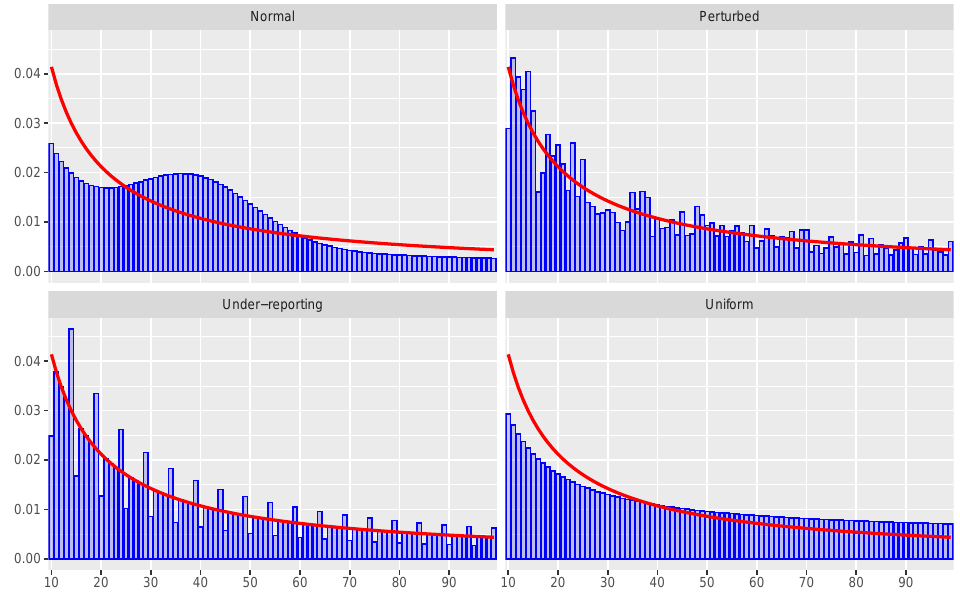
Figure 1. Probability function of the first-two-digits Benford’s law (red) compared to the probability functions of the mixtures used under the alternative hypothesis (blue). In the figure, a mixing parameter λ = 0.6 was used to exaggerate the visual effect. Larger values of λ were used in the simulations, with the consequence that the distribution under the alternative is closer to the distribution under the